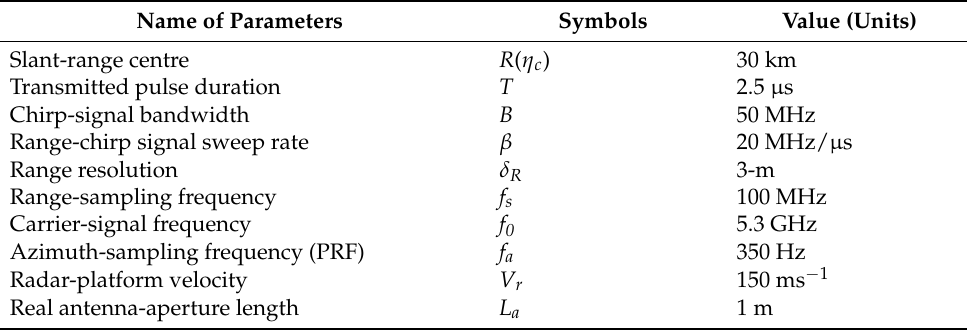
Table 1. Simulation parameters of C-band airborne